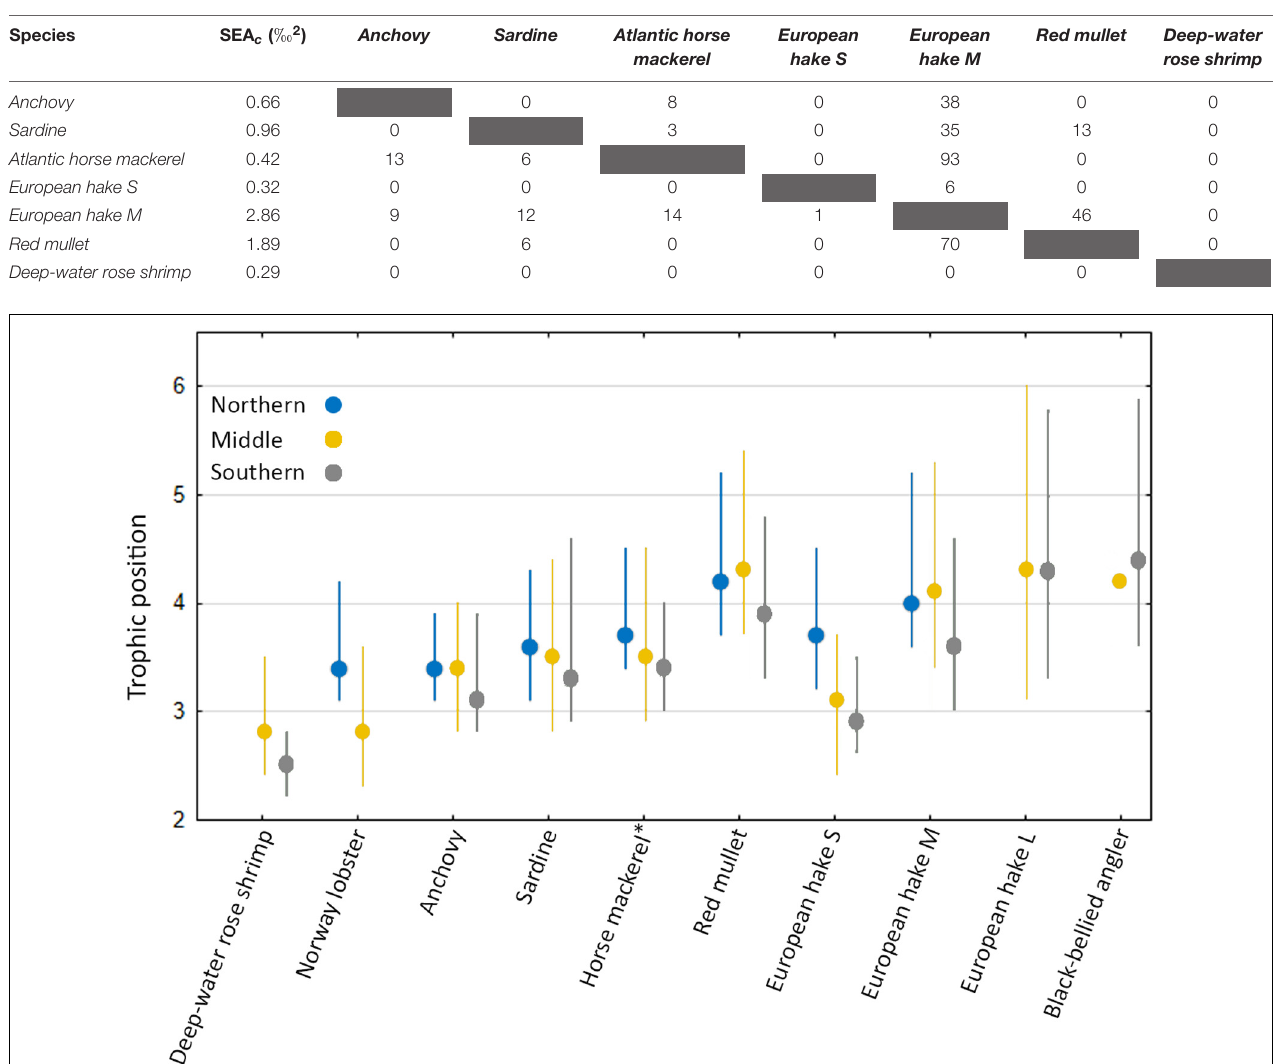
TABLE 6 | Standard Ellipse Area corrected for small sample (SEA c ) and SEA c overlap percentage between sampled species in the Southern Adriatic Sea (values indicate SEA c overlap of the species in the row with the species in the column).